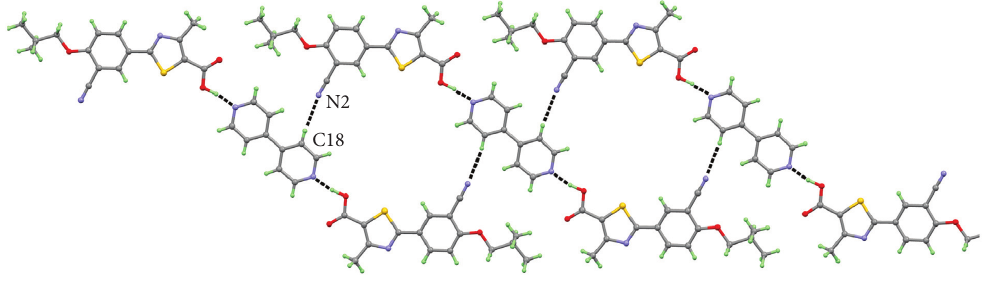
Figure 3: The two dimension sheet structures of FEB-BIP cocrystal.